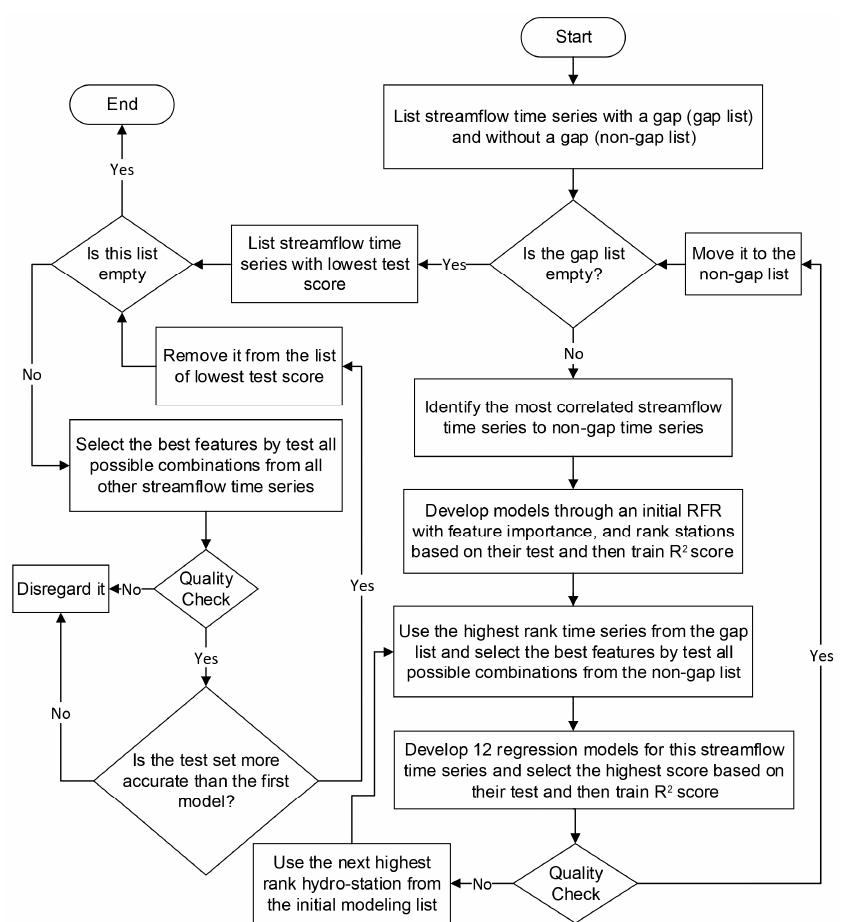
Figure 2. Reconstruction of streamflow time-series data through an iterative procedure using 12 ensemble regression methods. Initial gap list; 07AA001, 07AA002, 07AA004, 07AA009, 07AC001, 07AC007, 07AD002, 07AE001, 07AF002, 07AF013, 07AF014, 07AF015, 07AG001, 07AG003, 07AG004, 07AG007, 07BA001, 07BA002, 07BB002, 07BC002, 07BE001, 07CB002, 07CD001, 07CD005, 07CE002, 07DA001, 07DA041, and 07DD001. Initial nongap list: 07BE001 and 07CD001. In the development of models for each monthly streamflow time series, the optimal parameters were determined through a separate iterative process, and these parameters were subsequently